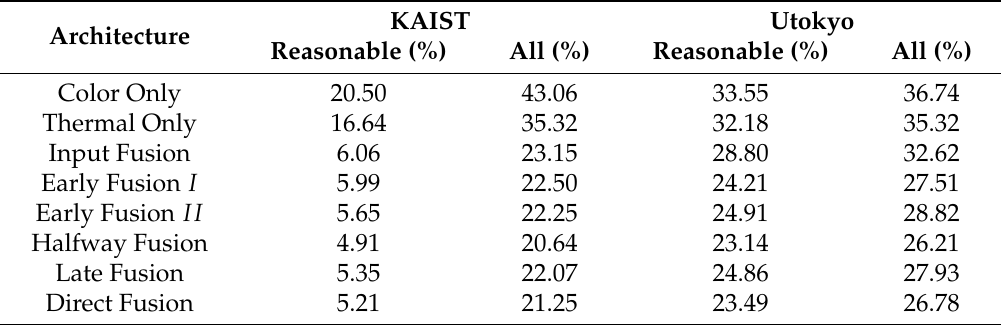
Table 1. Comparison of different fusion architectures. Performance are evaluated in terms of log- average miss rate.